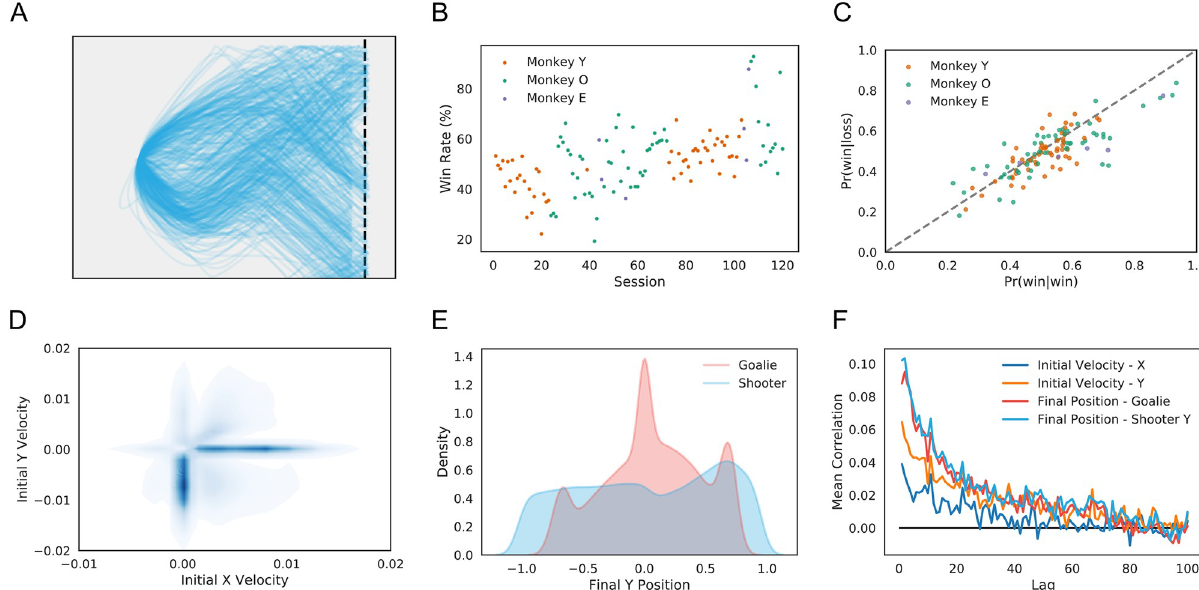
Fig 2. Variability in player behavior. A: Example trajectories from a single shooter, illustrating the diversity of player movements. B: Percentage of trials won by shooter for each behavioral session. Colors indicate shooter identity. Task parameters (puck speed, goalie size) were altered on a per- session basis to balance game play between players. C: Correlations in game outcome. Scatter plot of the probability of a shooter win as a function of shooter win or loss on the previous trial. Each dot represents one behavioral session. Colors indicate shooter identity. Game outcomes did not differ markedly following wins or losses. D: Distribution of initial velocities over all shooters. Shooters tended to start by moving immediately rightward, toward the goal line, or directly downward. E: Distribution of final vertical positions. Final goalie positions were peaked around 0 and either end of the screen, while shooter final positions were more evenly distributed over the game space. F: Autocorrelation in initial movement and final position across trials. Shooters’ initial movement direction and both players’ final vertical positions exhibited weak correlation across trials, indicative of short-term patterns in strategy. Curves are averages across behavioral sessions. Colors indicate